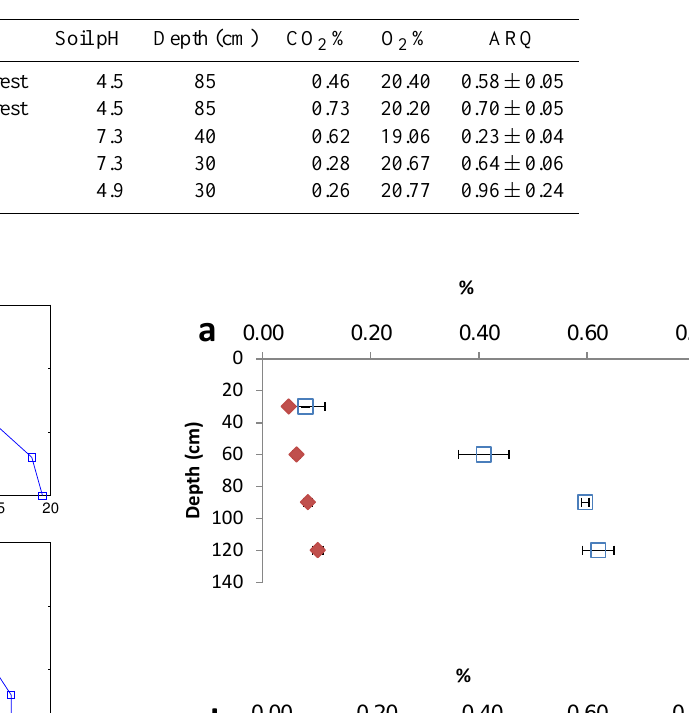
Table 1. The [CO 2 ], [O 2 ], and ARQ (average values of replicates) for in situ measurements in acidic and neutral soils in temperate and alpine forest sites (sites 4, 5, 6). Apparent respiratory quotient (ARQ) values different from the 0.9 ± 0.1 expected for respiration (based on plant composition) were observed in these soils.